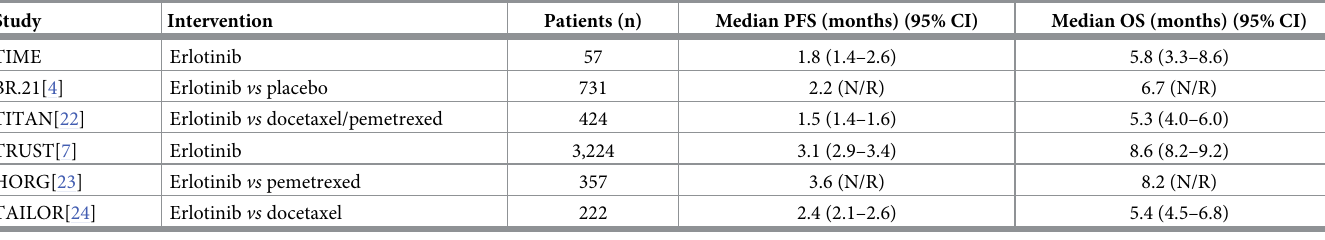
Table 3. Overview of available outcome data with erlotinib as a second-line